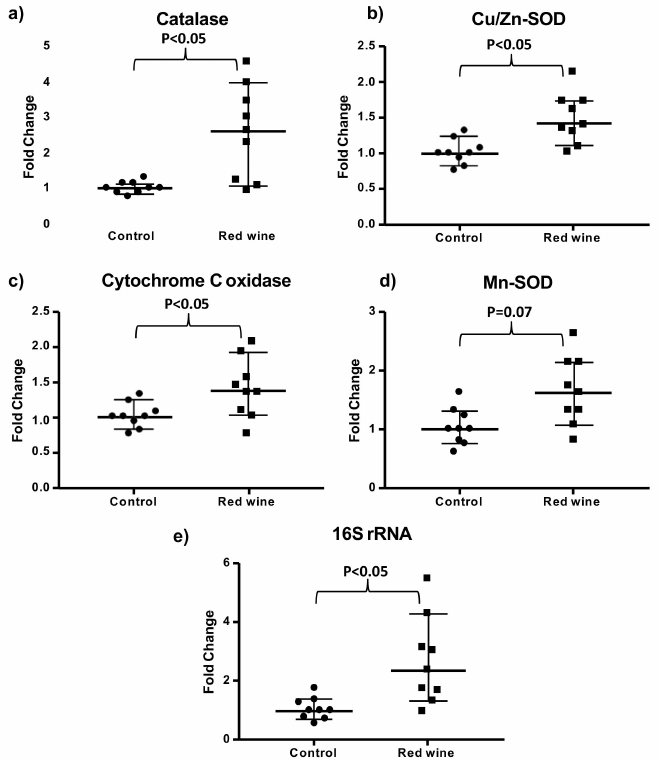
Figure 6. Gene expression in flies treated with or without red wine. Results are shown as median and range with 95% CI for ( a ) catalase, ( b ) Cu/Zn superoxide dismutase, ( c ) cytochrome c oxidase, ( d ) Mn-superoxide dismutase, and ( e ) 16S rRNA. Significance is shown in the